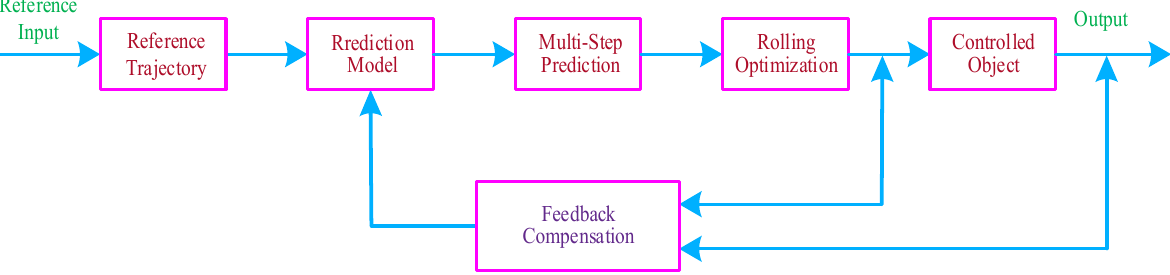
Figure 3. Block diagram of the model predictive control algorithm.